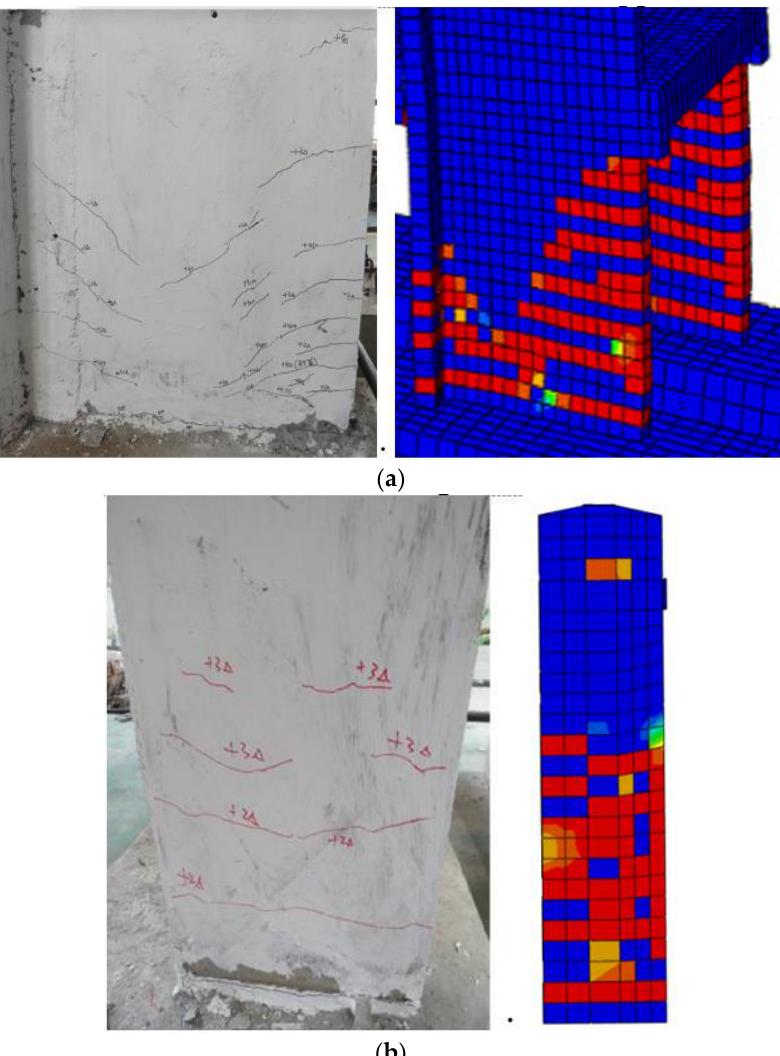
Figure 10. Comparison of experimentally measured cracks and finite element simulation cracks. ( a ) Experimentally measured cracks and finite element simulation cracks of the web; ( b ) Experimentally measured cracks and finite element simulation cracks of the flange.